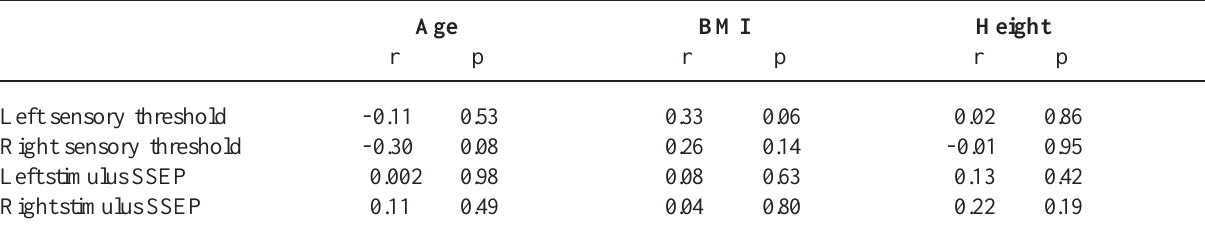
r = Pearson correlation coefficient; SSEP = somatosensory evoked potential.